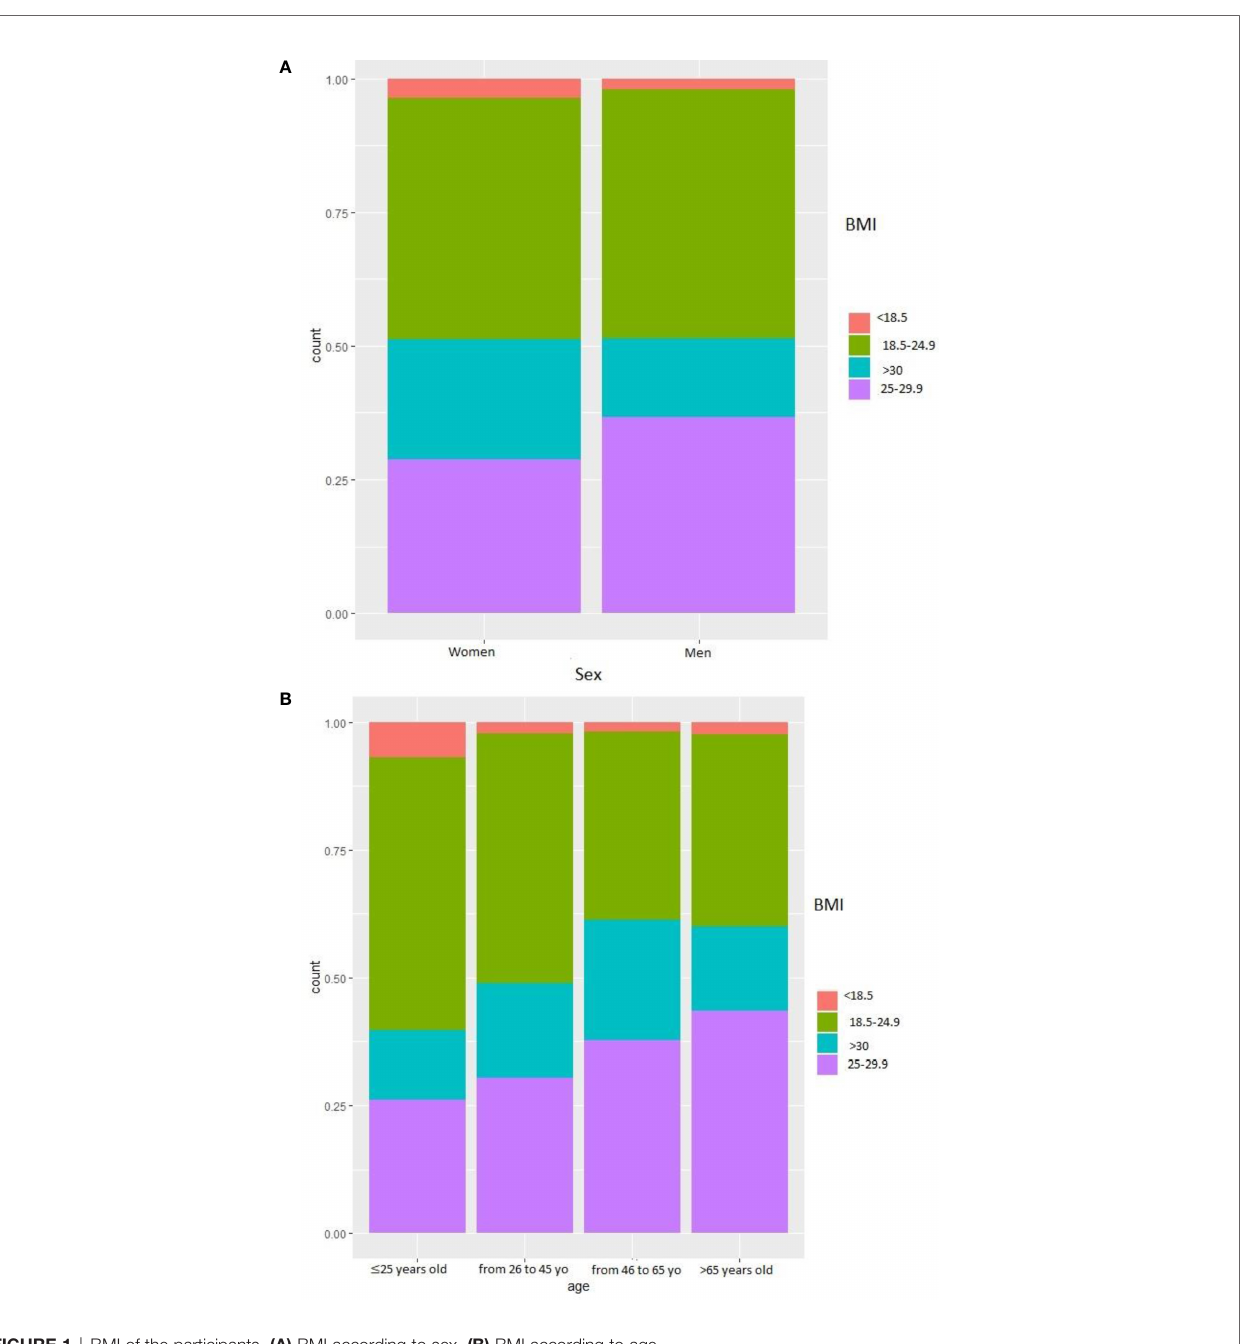
FIGURE 1 | BMI of the participants. (A) BMI according to sex. (B) BMI according to